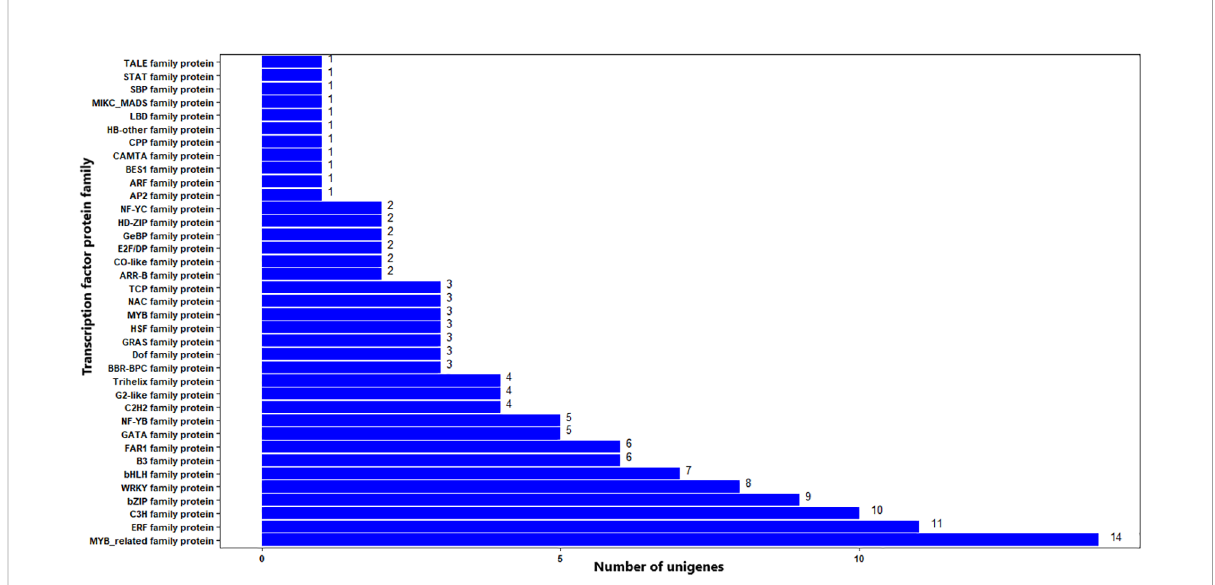
FIGURE 10 TF distribution of signi fi cantly differentially expressed genes. The Y-axis is the name of the TF family proteins, and the X-axis is the number of unigenes annotated to each TF family